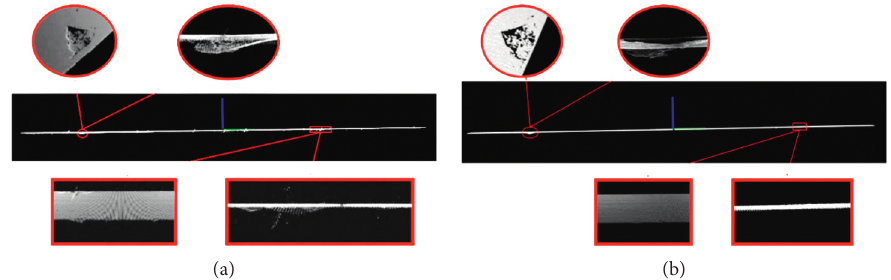
Figure 7: The results of point cloud denoising for the roller with a contact surface width of 6 mm. (a) Point cloud before the denoising roller and (b) point cloud after the denoising roller.